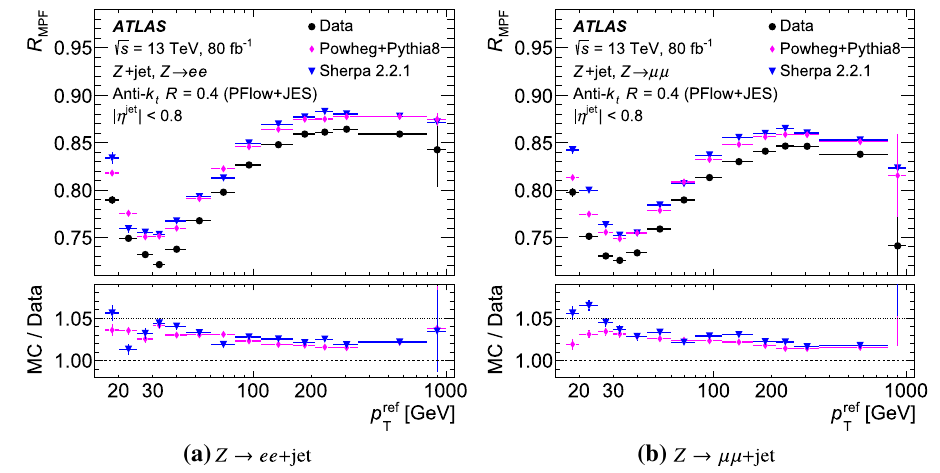
Fig. 11 Average PFlow jet response as a function of reference p T for Z +jet events where the Z boson decays into a electrons and into b muons calculated using the MPF technique. Z → ee and Z → μμ events are combined at a later stage. The black points correspond to 2015–2017 data while the pink diamonds and blue triangles correspond